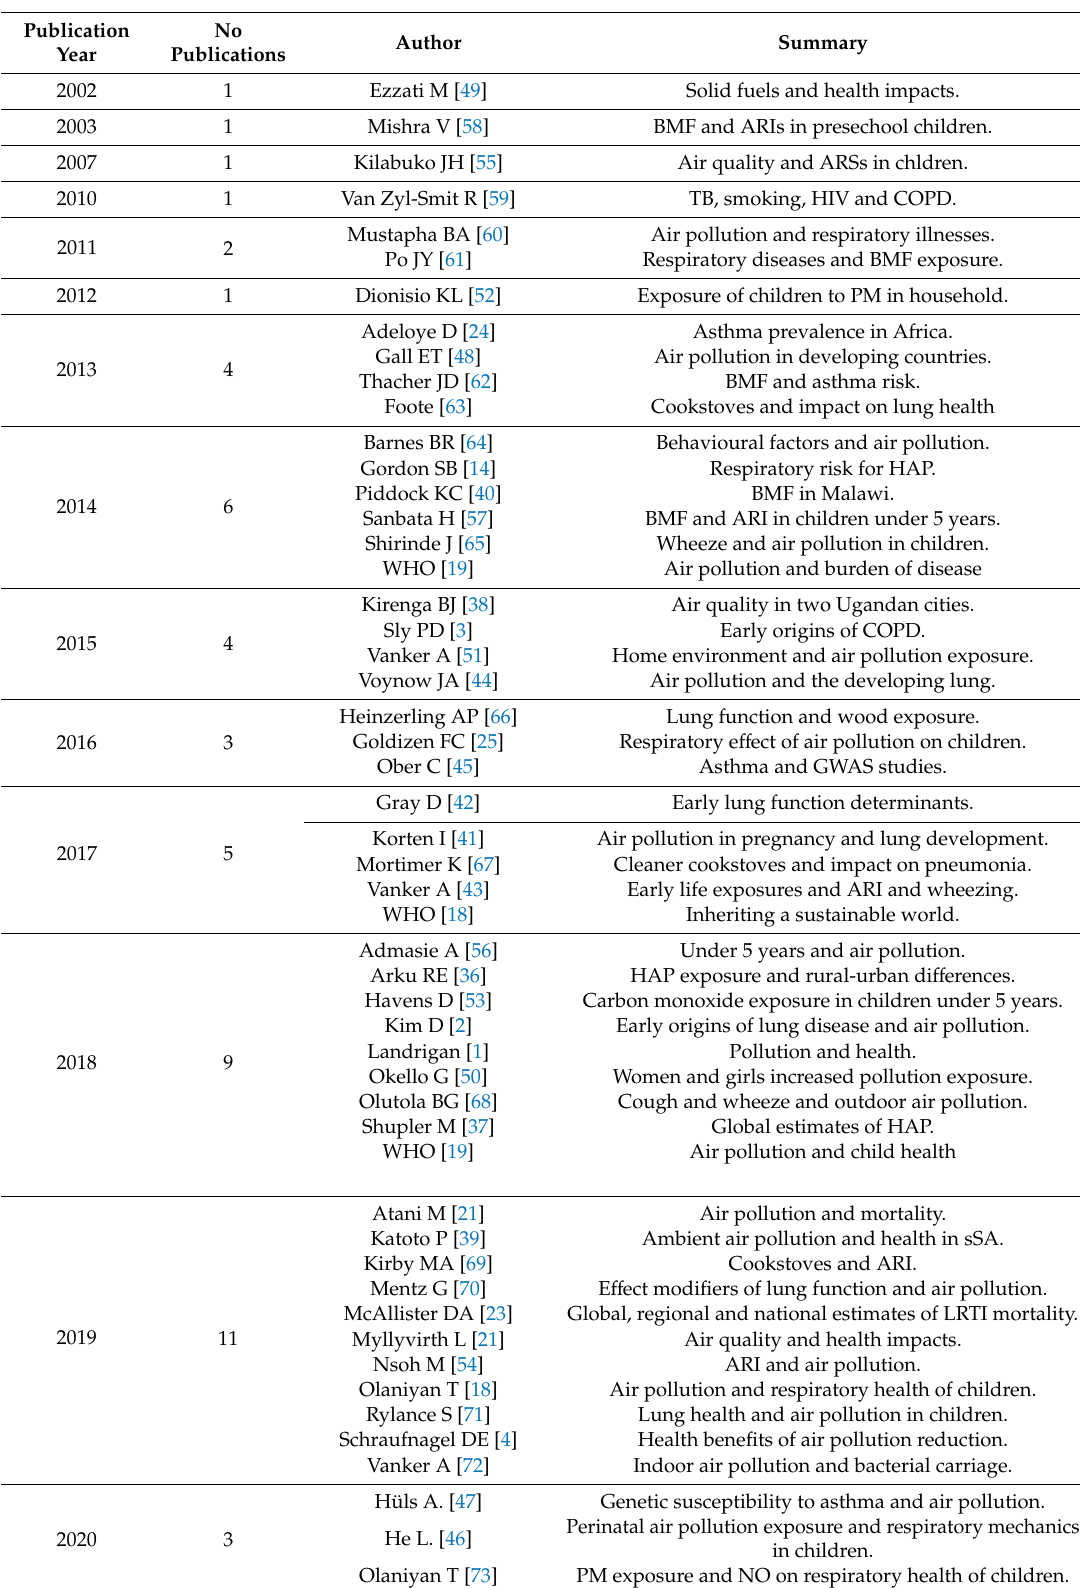
Table 1. Selected papers for inclusion and publication